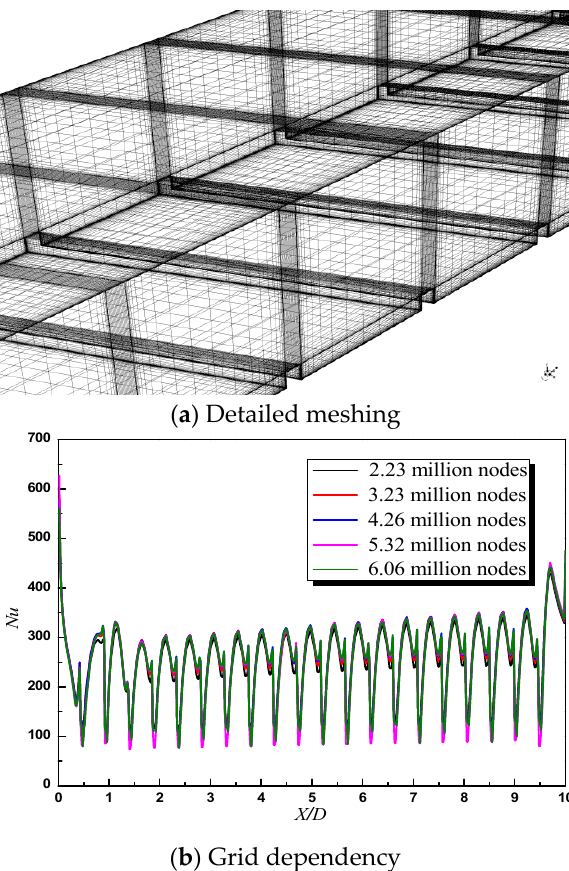
Figure 2. Grid characteristics: ( a ) detailed meshing and ( b ) grid dependency.